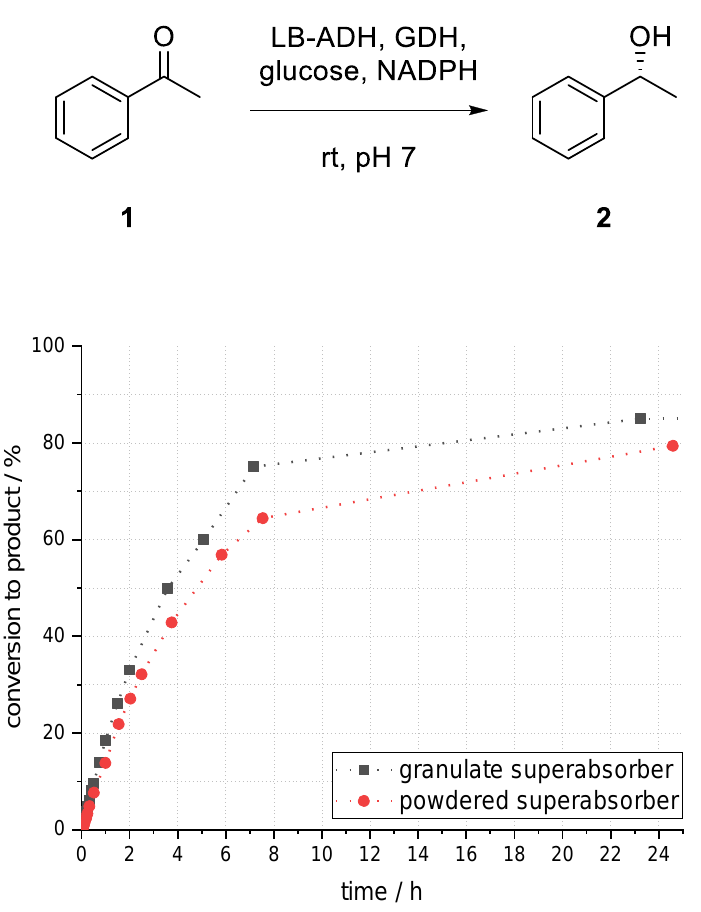
Figure 10. Influence of superabsorber particle size on the conversion to phenylethanol ( R )- 2 in an enzymatic reduction of acetophenone ( 1 ) using ADH in superabsorber-immobilized aqueous phase.